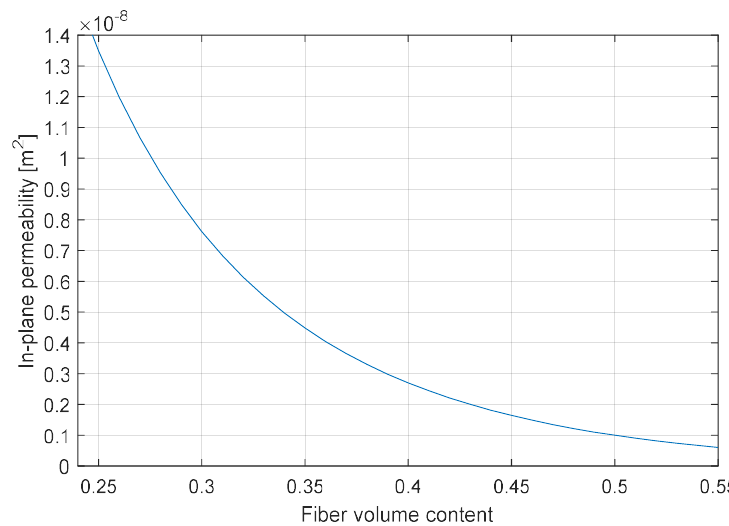
Figure 10. In-plane permeability ( K 1 , K 2 ) curve for the C-RTM process simulations for the second hood geometry.